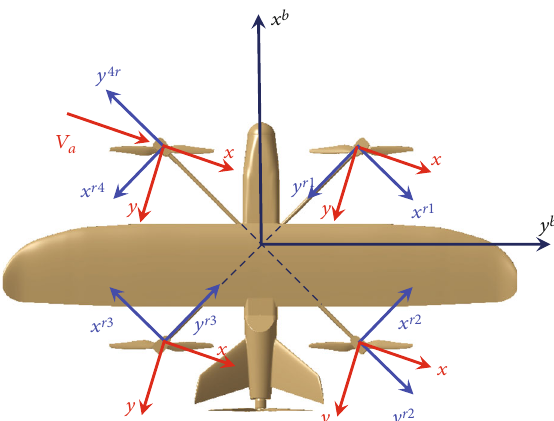
Figure 4: The relationship between oxyz and o ri x ri y ri z ri axes.